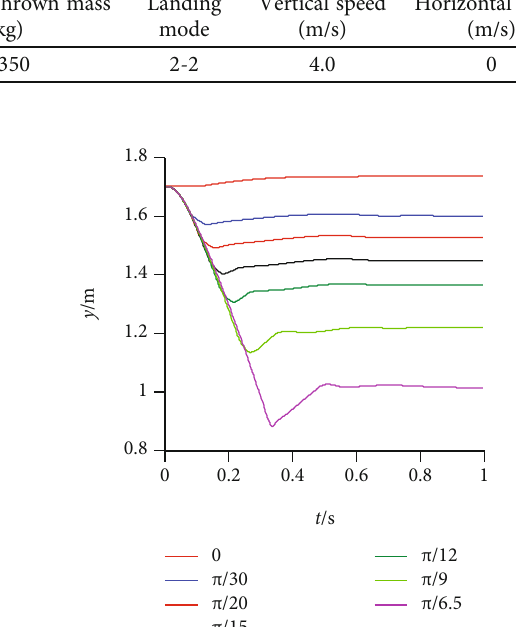
Figure 18: Body displacement vs. time.